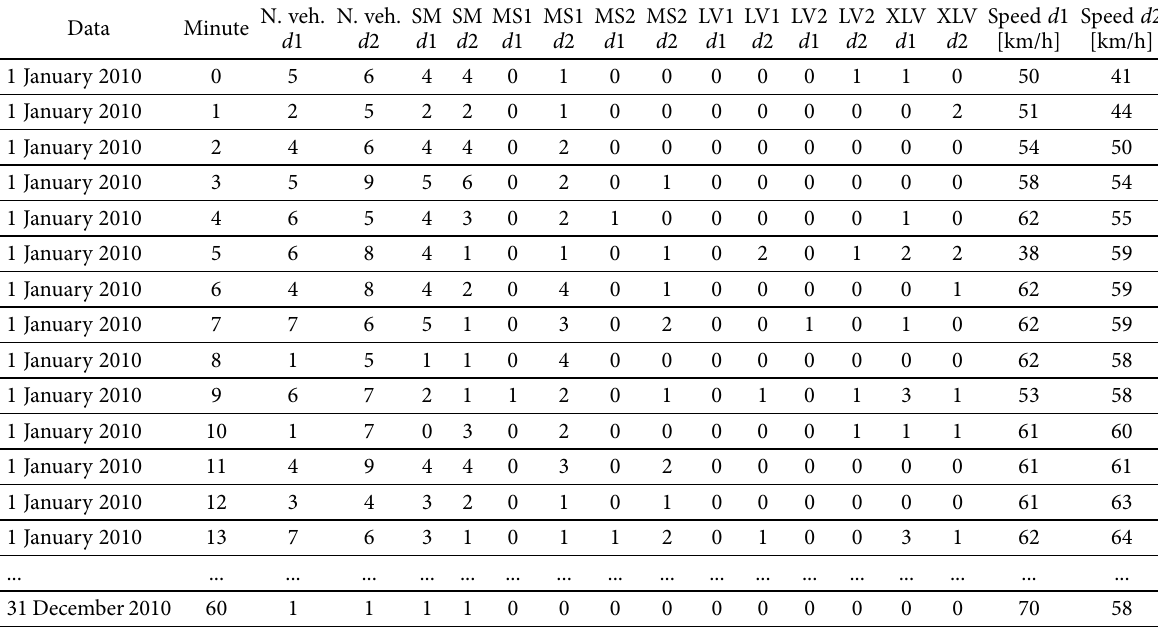
Table 1. Organization of